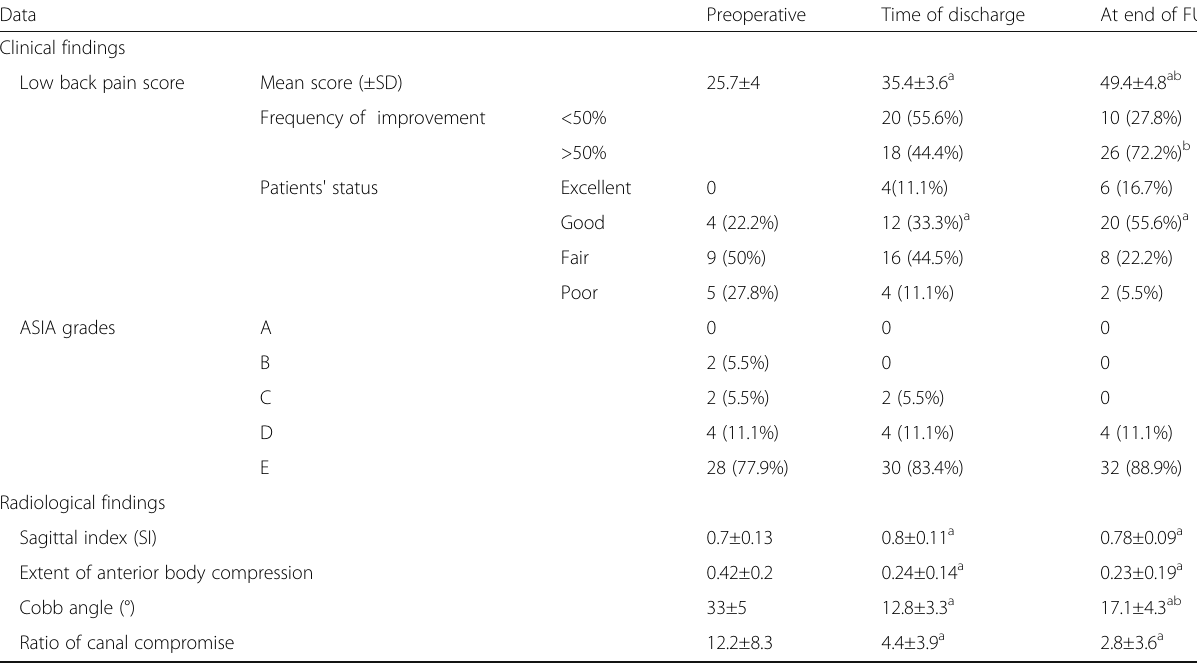
Table 4 Clinical and radiological evaluation data determined at time of discharge and at end of follow-up